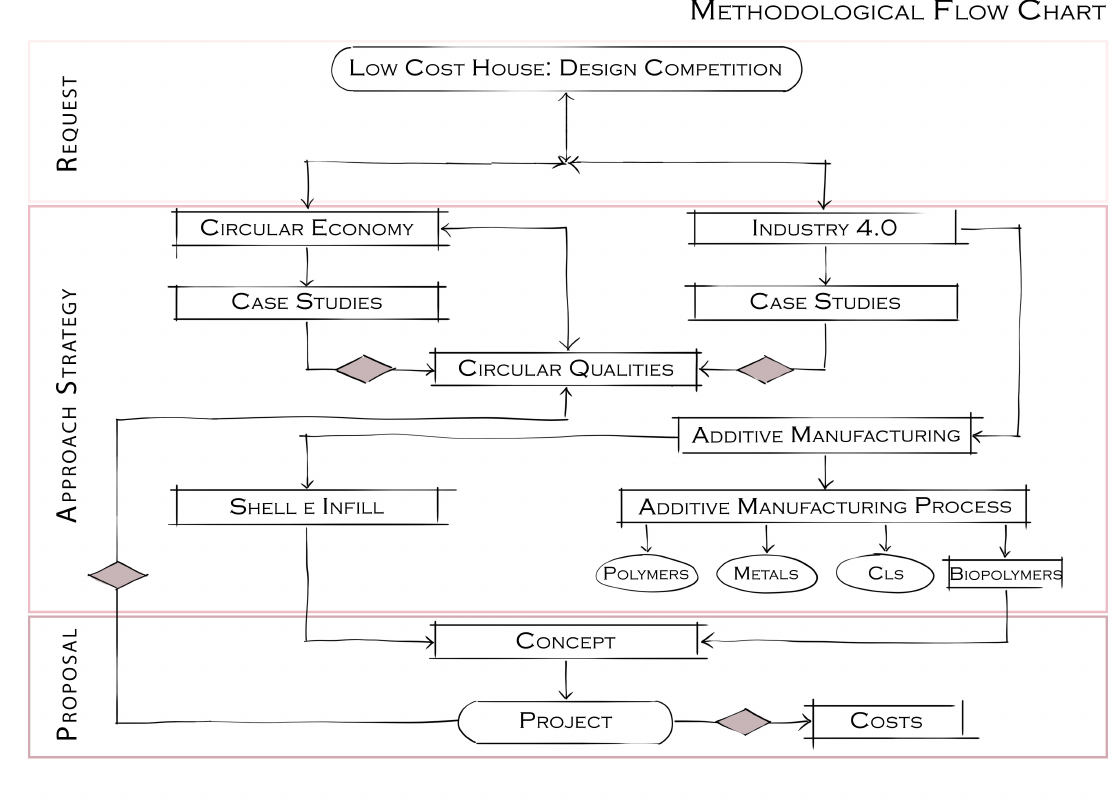
Figure 1. Methodological